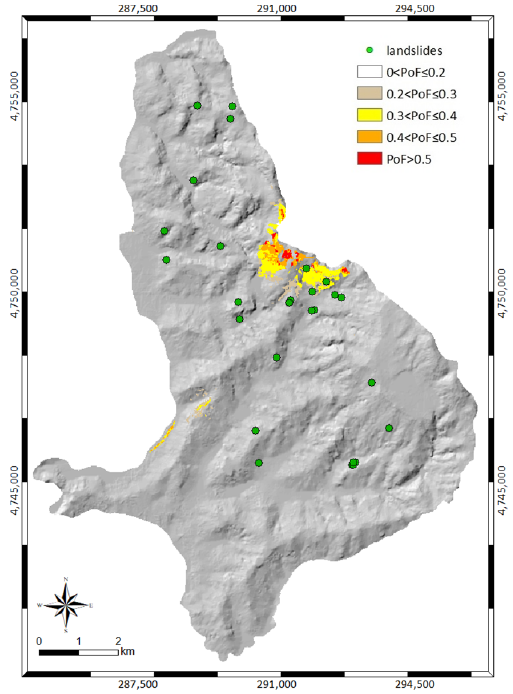
Figure 6. The image shows the PoF distribution considering natural conditions for the soil cover and the rainfall event described in Figure 3. For the soil characterization, the mechanical properties used are reported in Table 1.